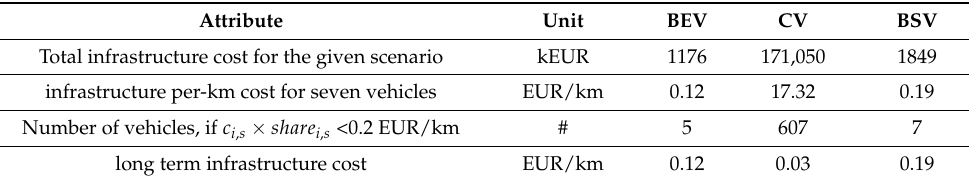
Table 7. Infrastructure